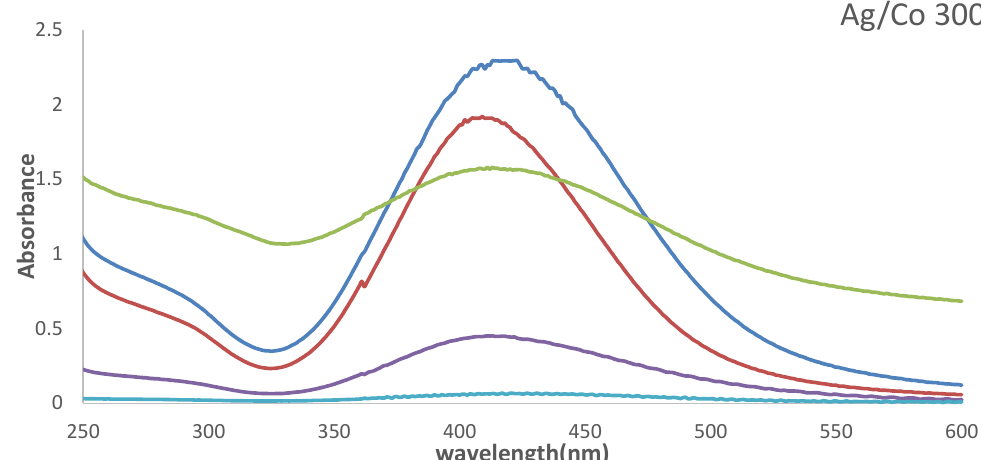
Fig. 6: Absorption spectra of silver-cobalt nanoparticles produced from silver nanoparticles at a different time interval of 300 seconds on the first, second, third, seventh, and fourteenth days (The electrical current adjusted at 1amp and rotational speed was 3000 rpm).